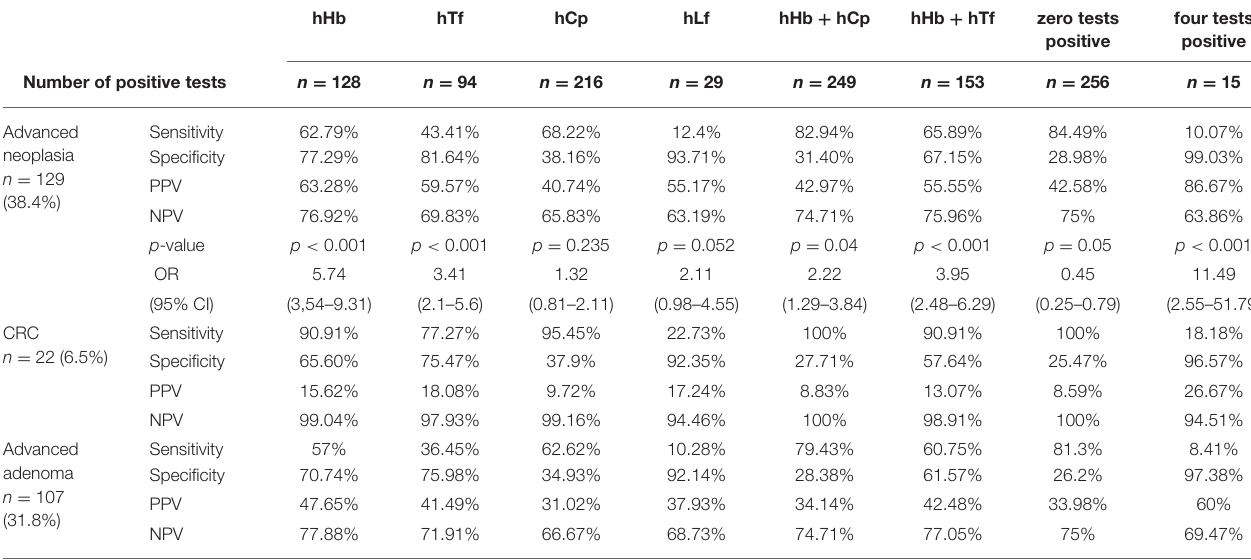
TABLE 3 | Diagnostic accuracy of the four biomarker semi-qualitative combo test.